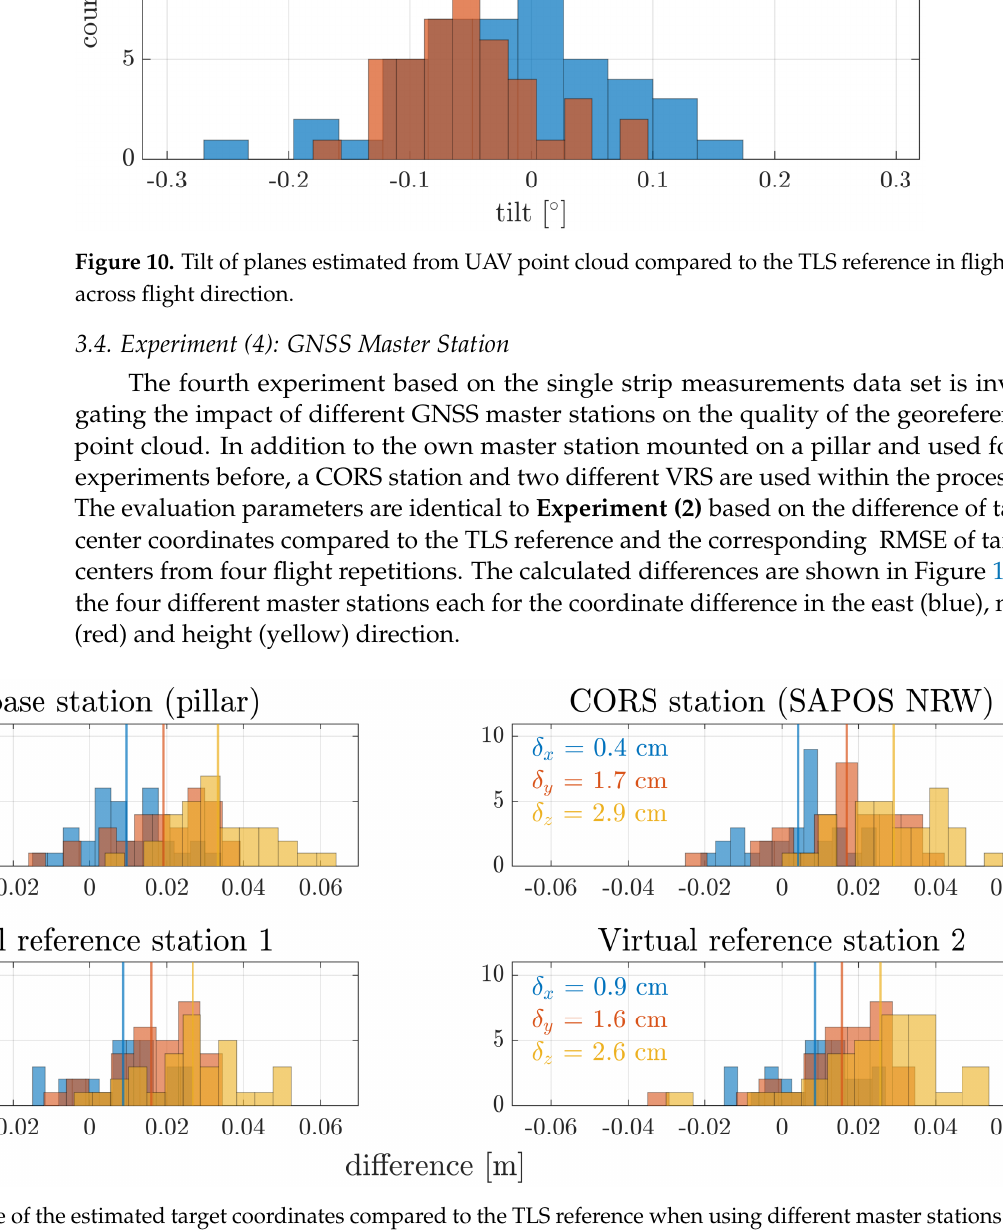
Figure 11. Difference of the estimated target coordinates compared to the TLS reference when using different master stations for the trajectory estimation. In addition to the own master station used before, a CORS station and two VRS are used. The histograms show the combined results for four flights and all targets included considering the east (blue), north (red) and height (yellow)